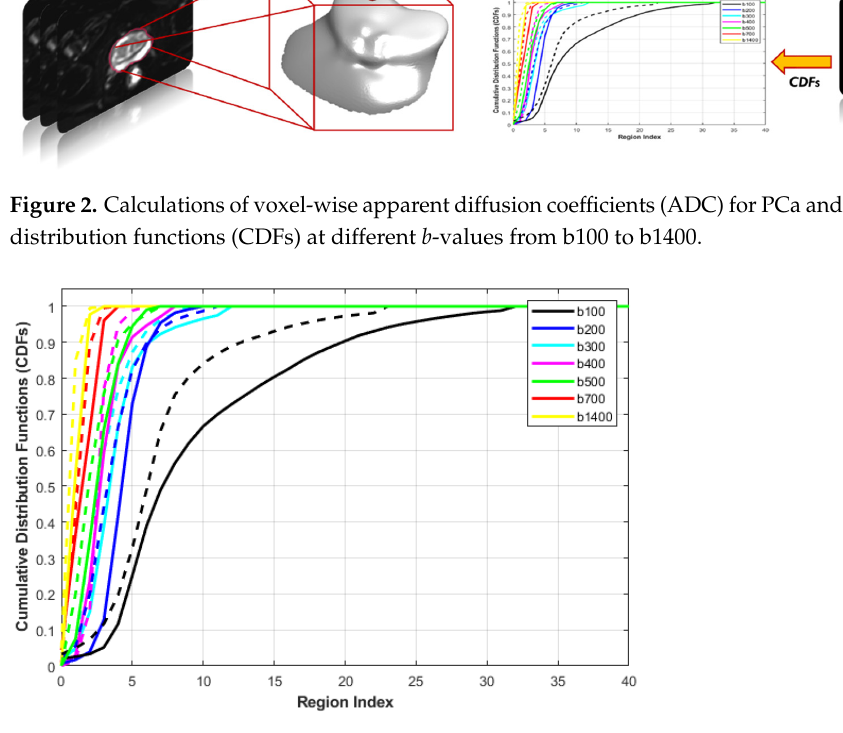
Figure 3. CDFs of ADC values for a benign case (solid) vs. a malignant case (dotted) for ADC maps obtained using different b -values from b100 to b1400. Note that region index indicates the different regions where the ADC values within the same range falls into.